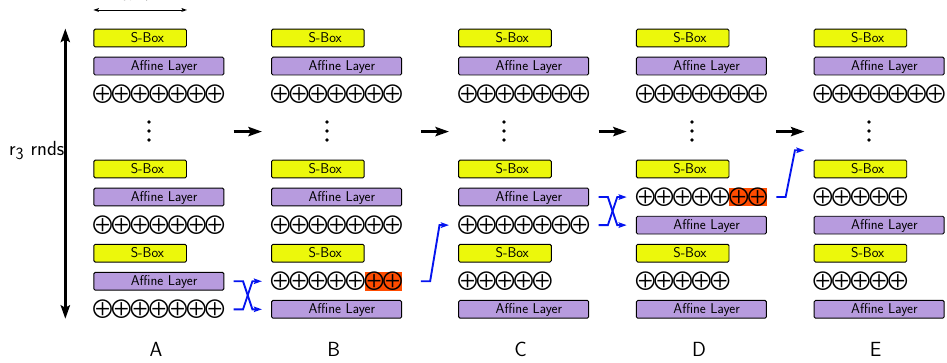
Figure 4: Transforming the round function in the final r 3 rounds. A → B flips the order of the last round Affine layer and round key xor. B → C takes the bits of the last round key that are not added to S-box outputs (shown in orange background), and brings them back by 1 round and merges it with the penultimate round key. C → D flips the order of the Affine layer and round key of the penultimate round, and D → E generalizes the process from this point